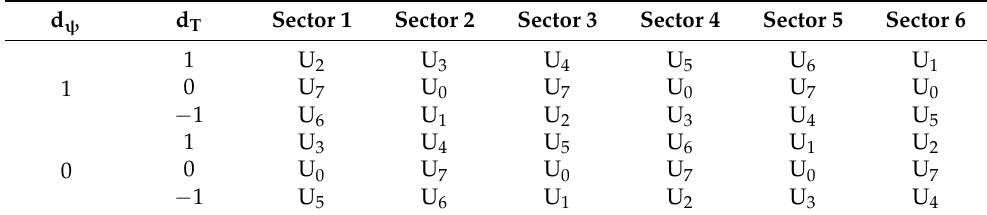
Table 2. Conventional DTC optimum switching table.